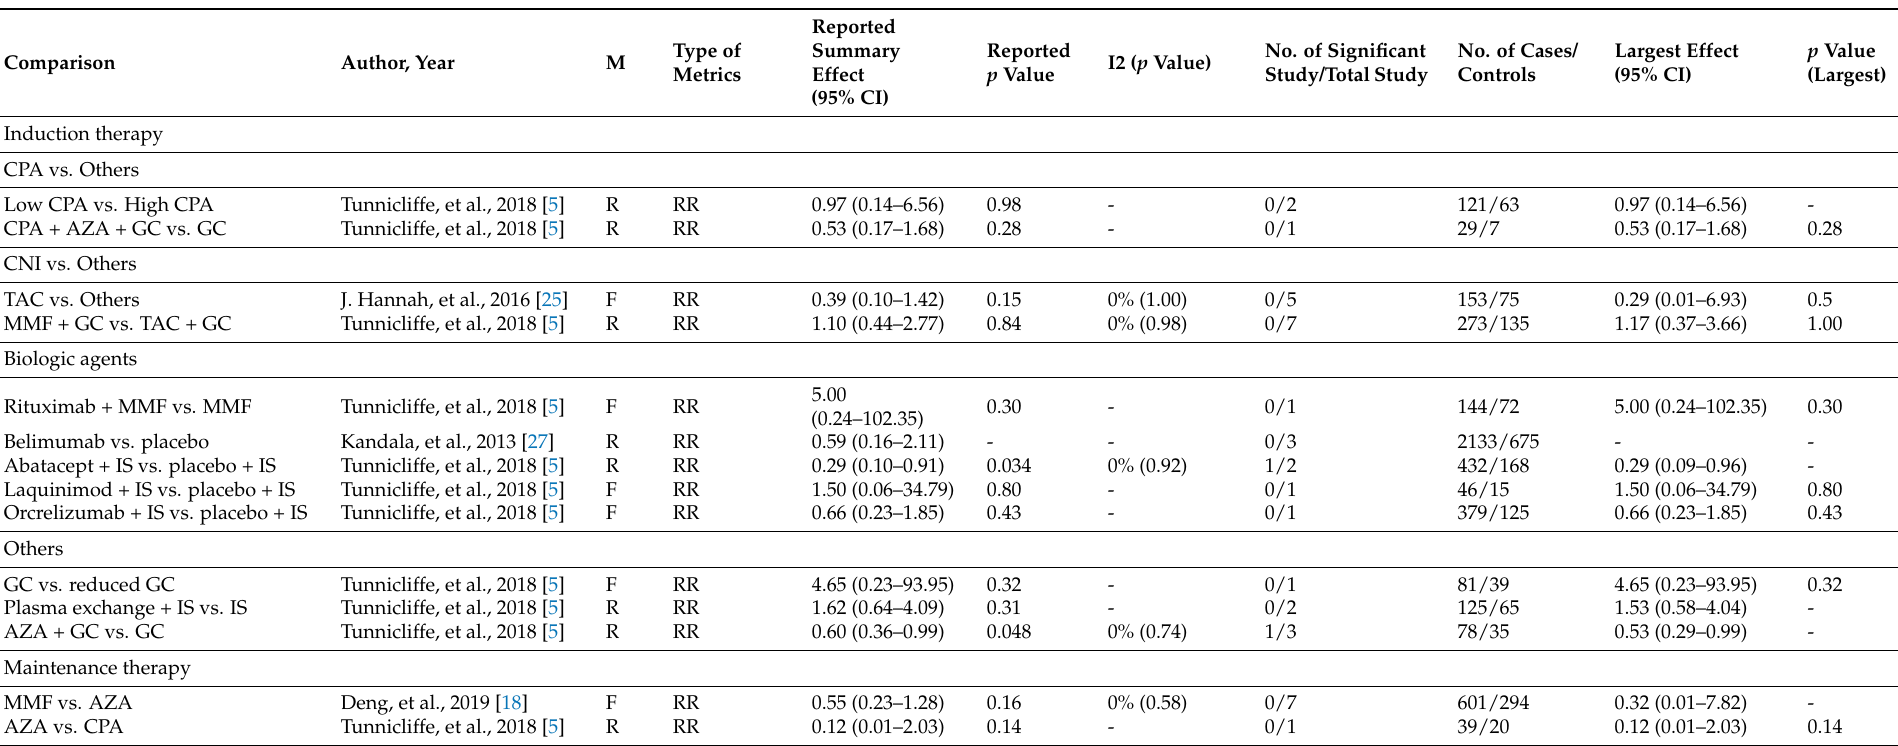
Table 7. Mortality during induction and maintenance therapy in lupus